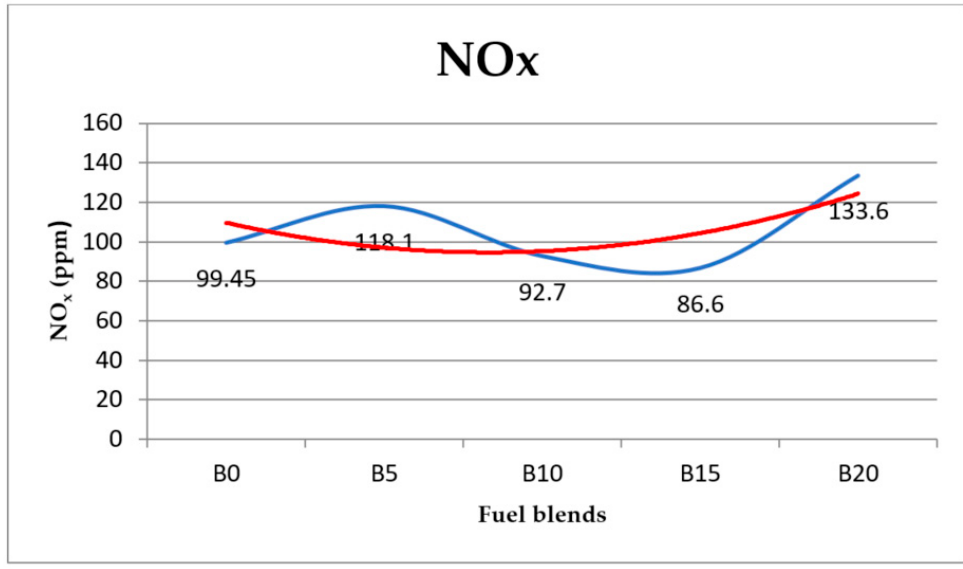
Figure 11. Nitrogen oxide from the electric generator.